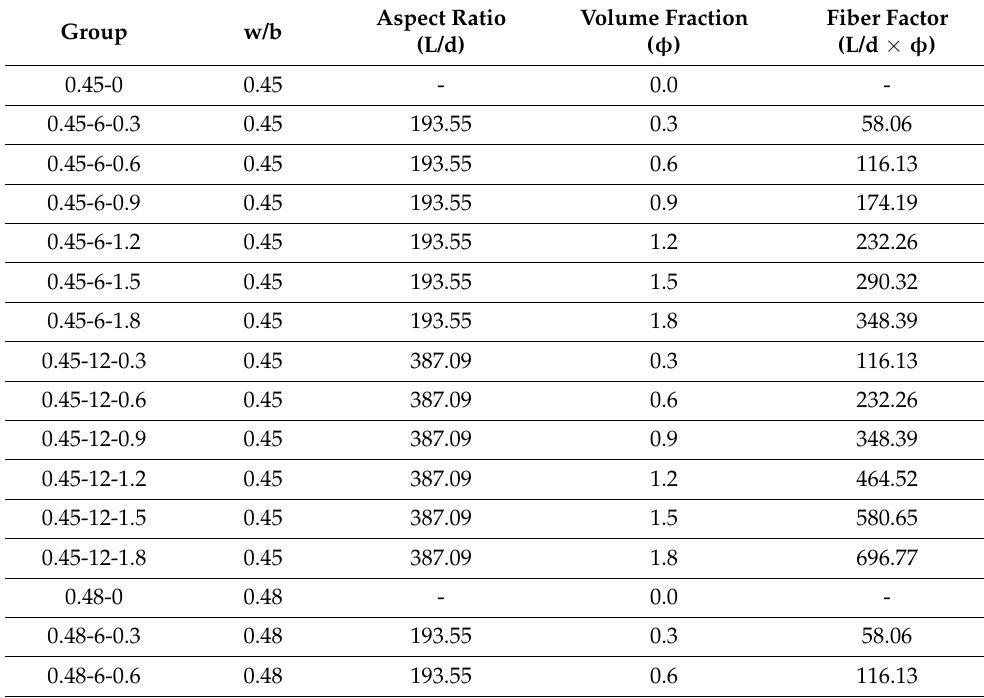
Table 3. Mixture proportions of fiber-reinforced